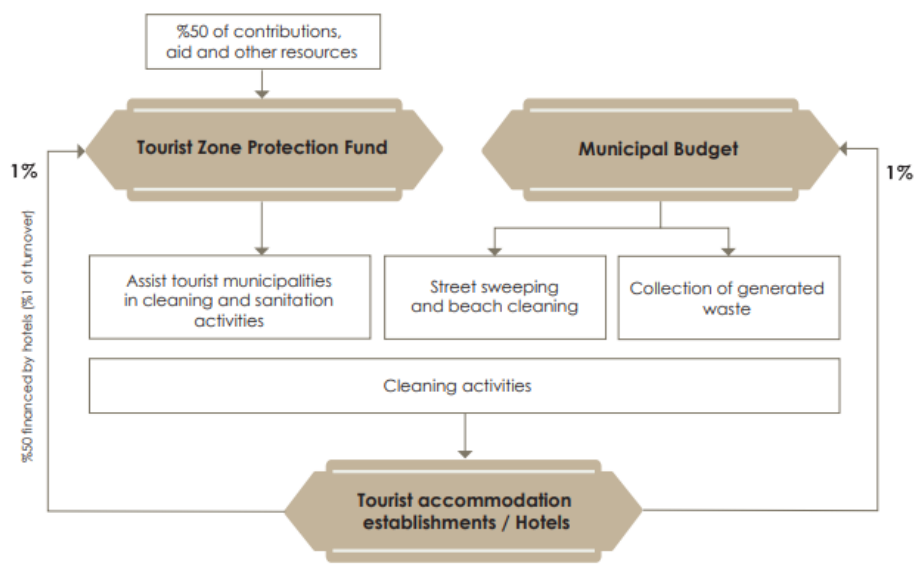
Figure 9. Financial system of SWM in tourist zones in Tunisia.